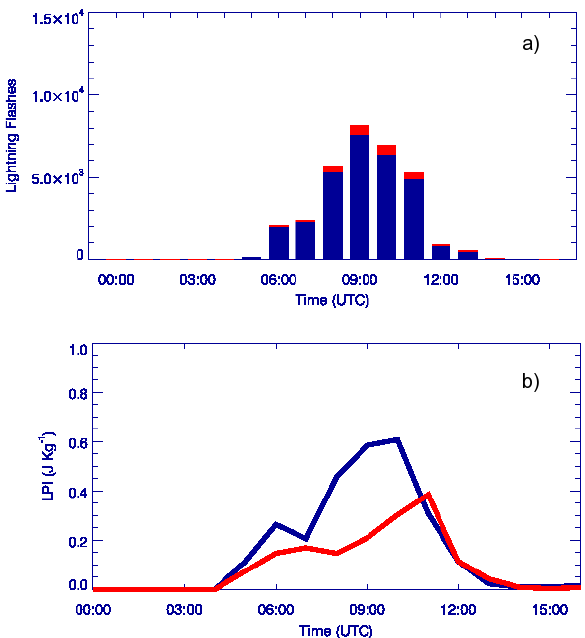
Figure 11. Fig. 11. Temporal evolution of observed total CG lightning flashes (a) and calculated domain-averaged LPI (b) . In (a) red denotes pos- itive flashes and dark blue denotes negative flashes. In (b) , red de- notes the C-case and dark blue denotes the